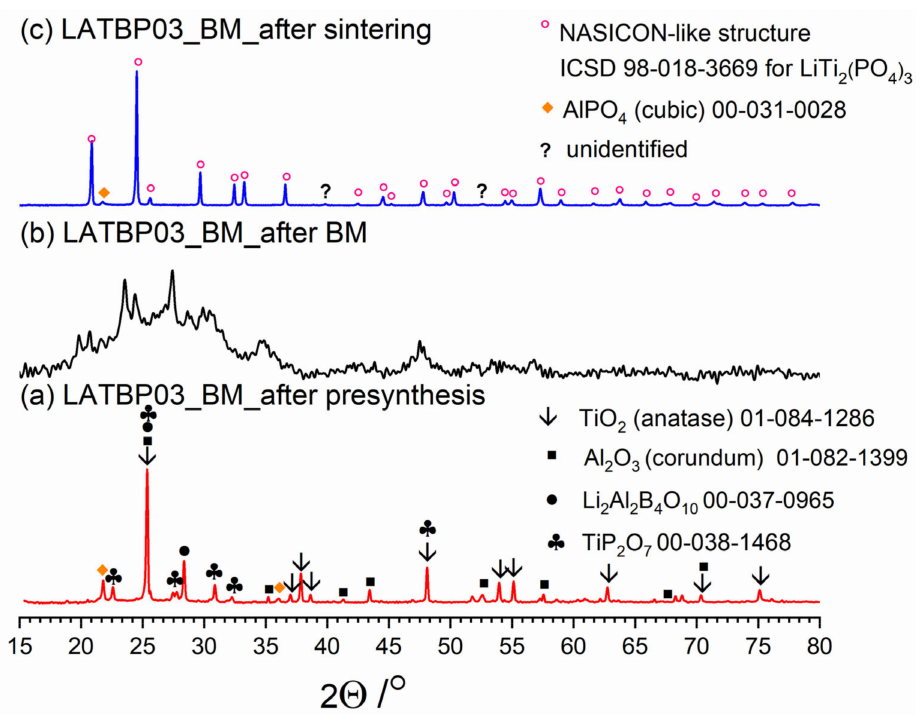
Figure 5. Diffractograms presenting different stages of LATBP03_BM_ceramic formation: ( a ) after presynthesis at 350 ◦ C for 3 h; ( b ) after ball-milling at 600 rpm for 72 h; ( c ) after heat treatment at 900 ◦ C for 12